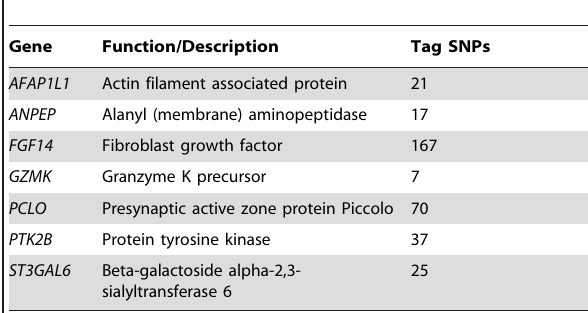
Table 1. Selected genes, their function and the number of tag SNPs required to reach 100% coverage at m.a.f. . 0.1 and r2 .